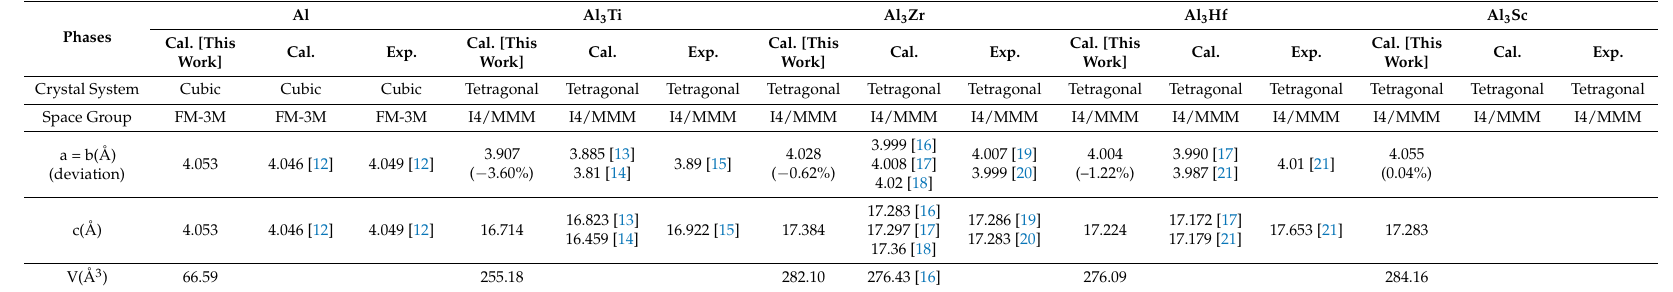
Table 1. Lattice parameters of the calculated Al 3 TM (TM = Ti, Zr, Hf, Sc)